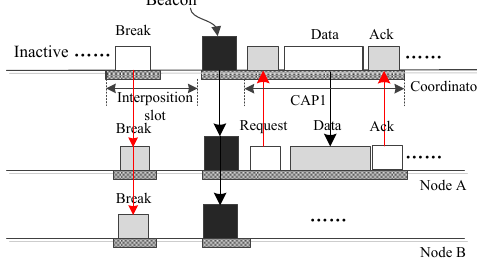
Figure 4. The coordinator sends big data to one node,